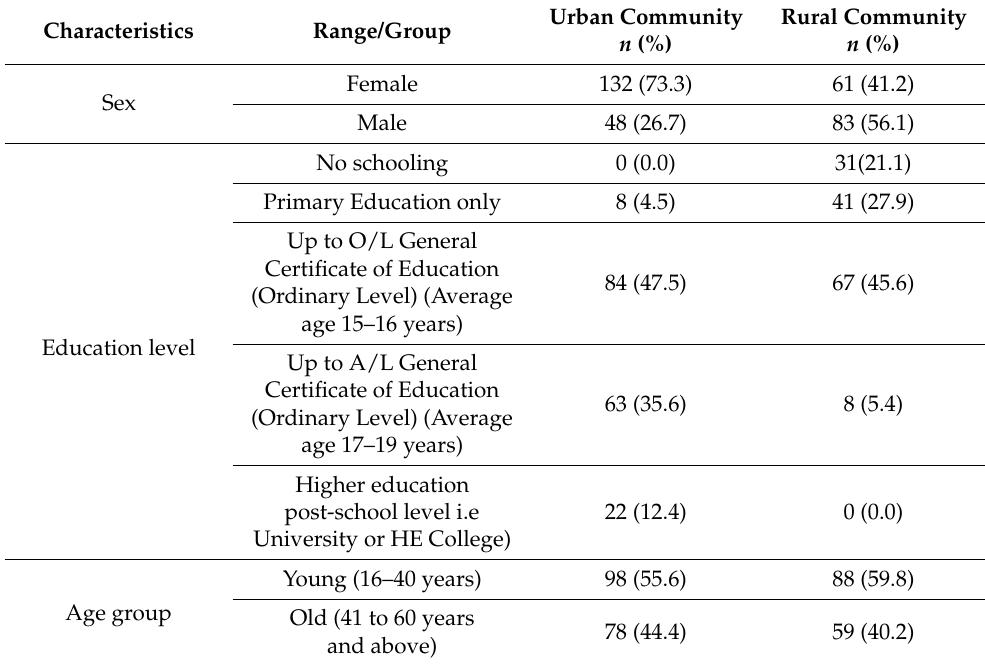
Table 1. Demographics of respondents in relation to the site, gender, age group, and highest education